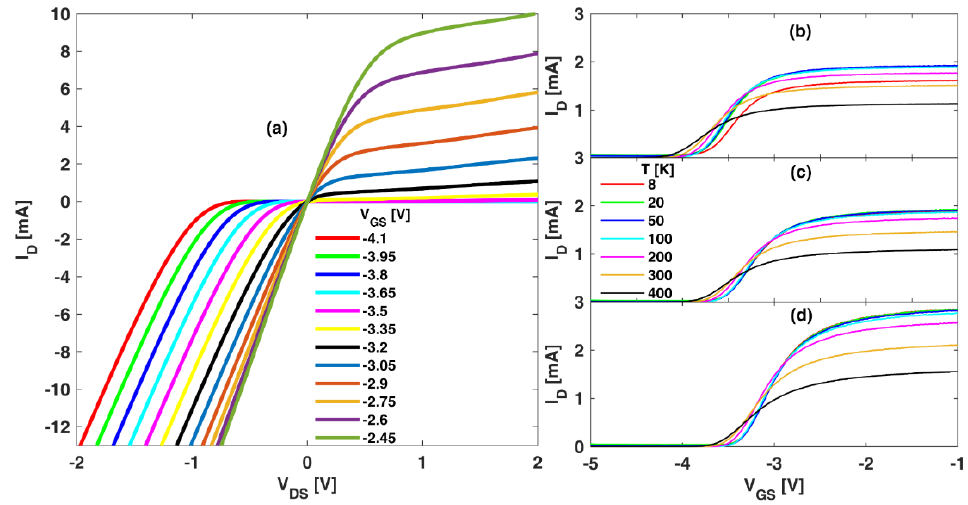
Figure 1. ( a ) I D − V DS output characteristics of the HEMT with L g = 250 nm and T = 300 K. All the operation regions are shown, including the third-quadrant conduction for negative V DS values. I D − V GS transfer characteristics for V DS = 0.1 V from 8 to 400 K for the three devices under test: ( b ) L g = 75 nm, ( c ) L g = 150 nm and ( d ) L g = 250 nm.